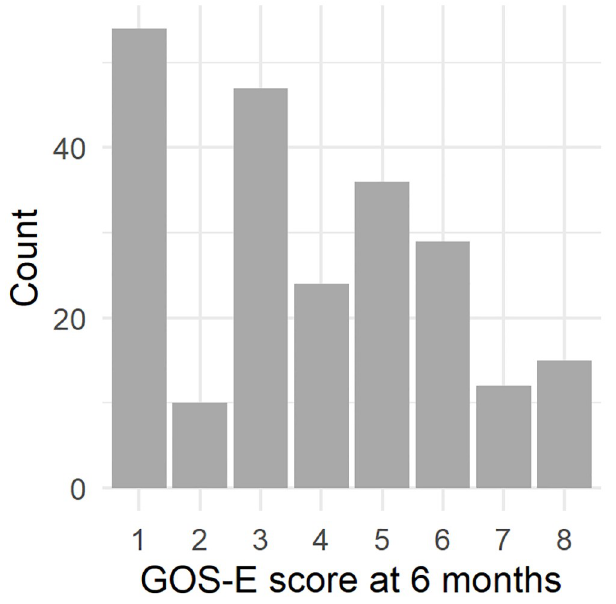
Fig 2. Distribution of GOS-E score at 6 months.